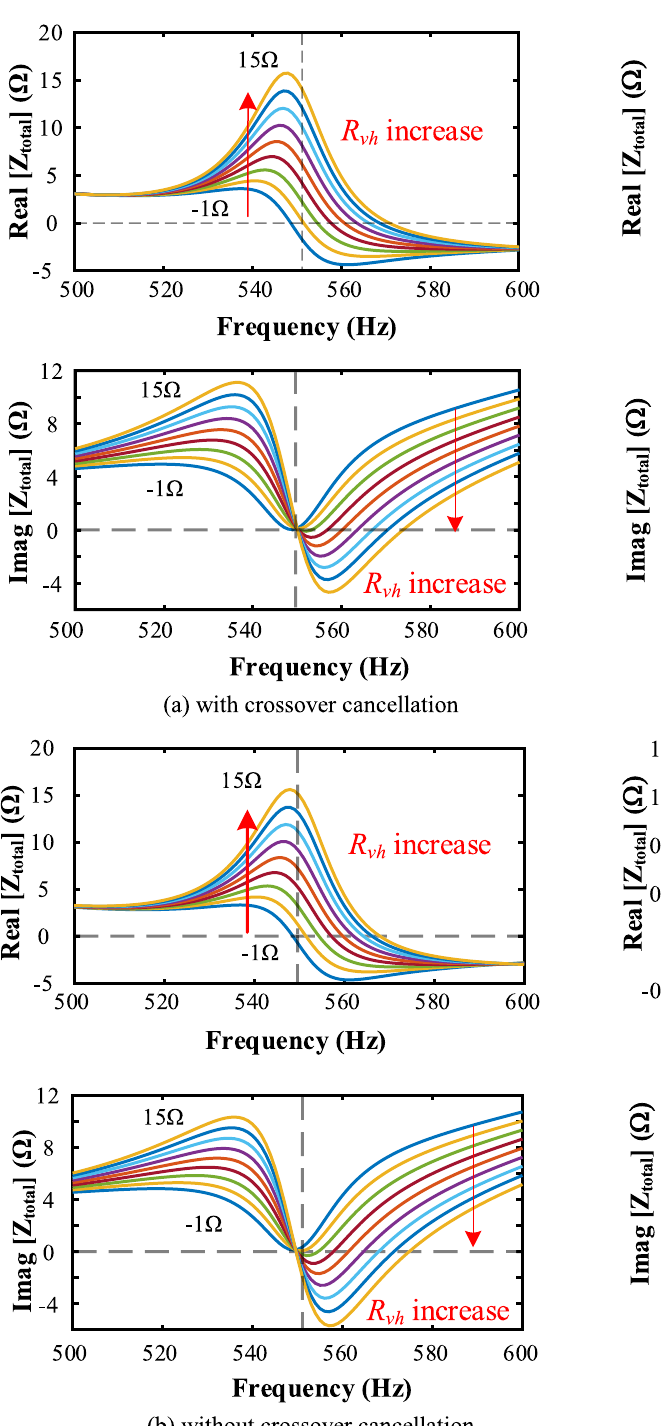
Fig. 9 Real and imaginary parts of Z total as R vh varies Fig. 10 The real part and imaginary part of Z total as L vh